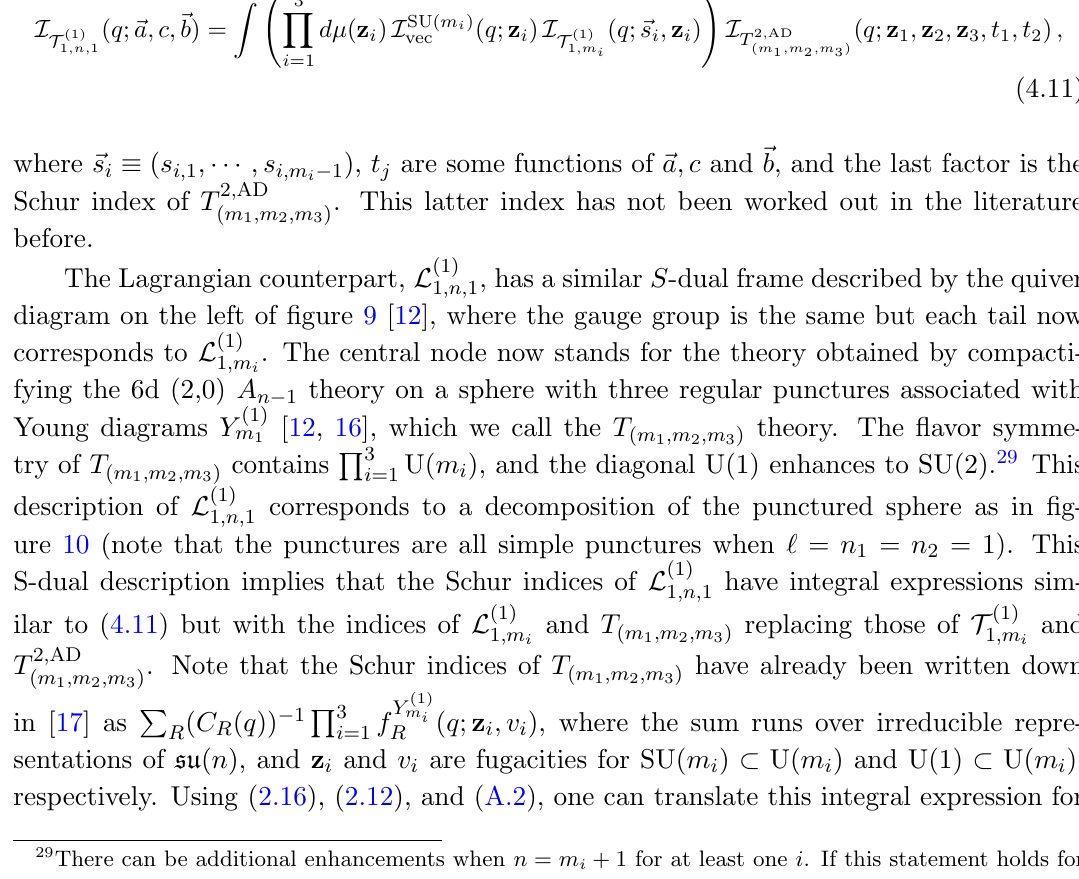
Figure 9 . The S-dual descriptions of L (1) m 1 + m 2 + m 3 = 2 n and 1 < m i < n . Here a circle with m i inside stands for an SU( m i ) gauge